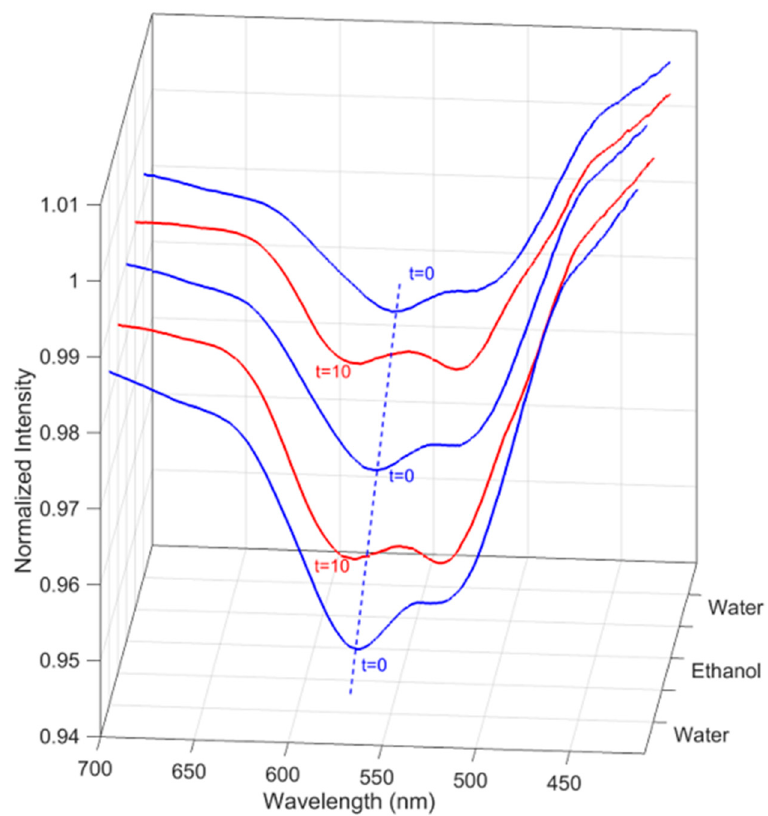
Figure 3. The nanogel–POF interface behaves as a reversible optical switch. The sensor was tested with the following cycle: water was placed on the interface (start of the cycle; t = 0, blue lines), followed by ethanol:water RI 1.339 (10% w / v ), let incubate for 10 min, and then measured (t = 10, red lines). At the cycle’s completion, the sensor was placed in water, incubated for 10 min, and the next cycle was started (t = 0, blue line). Three out of five consecutive cycles performed on the sensor are reported. It can be observed that when alternatively placed in water (blue line) and ethanol:water RI = 1.338 (red line), the optical minima shift between typical positions, hinting at possible uses of the nano-gel-POF as an optical switch.